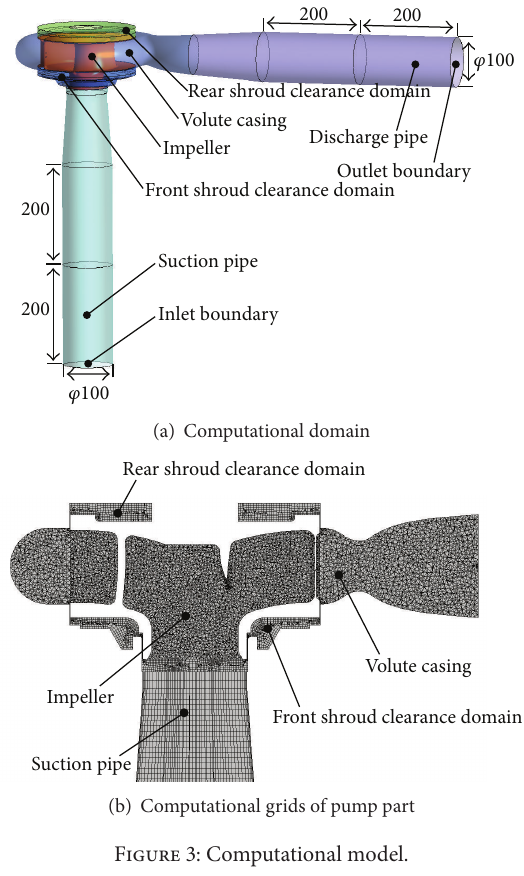
Figure 3: Computational model.